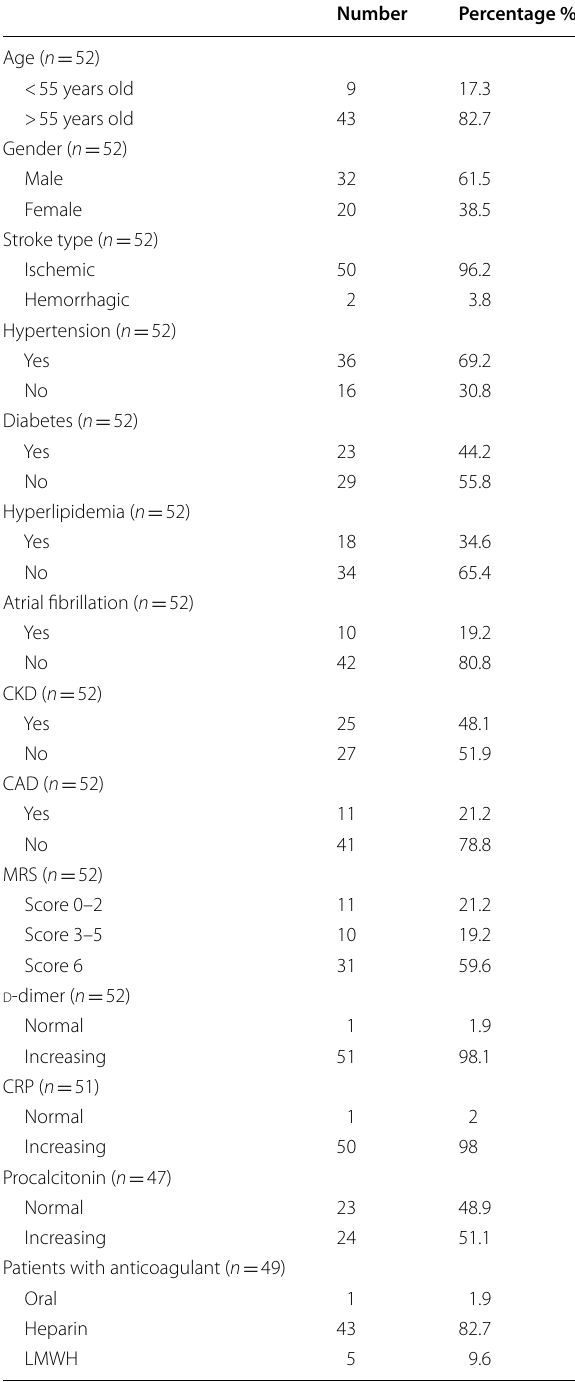
Table 1 Demographic characteristics and the risk factors of the